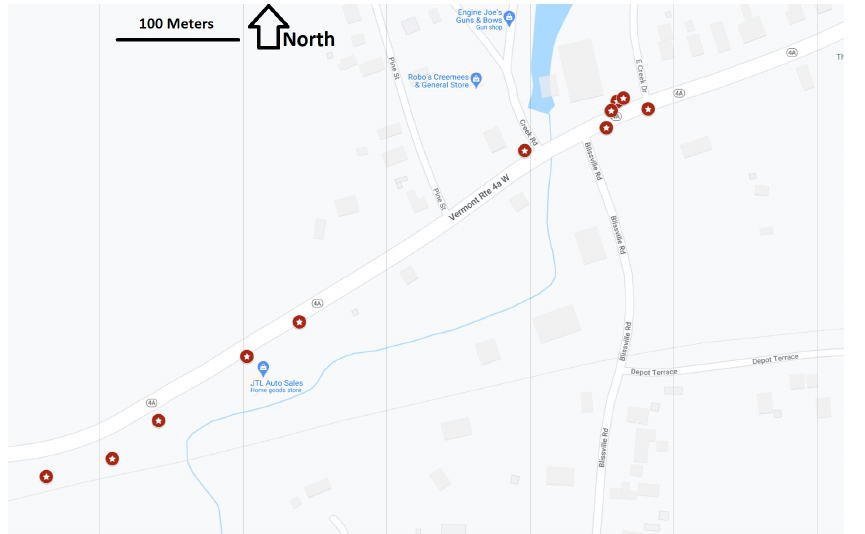
Figure 6. The end result of our pipeline is that signs are classified based on their sign type and placed on a map corresponding to their geo-location. Each dot indicates the location of a single sign after all the repeated detections have been merged. Properties of the sign such as its class can be inspected by clicking on it on the map